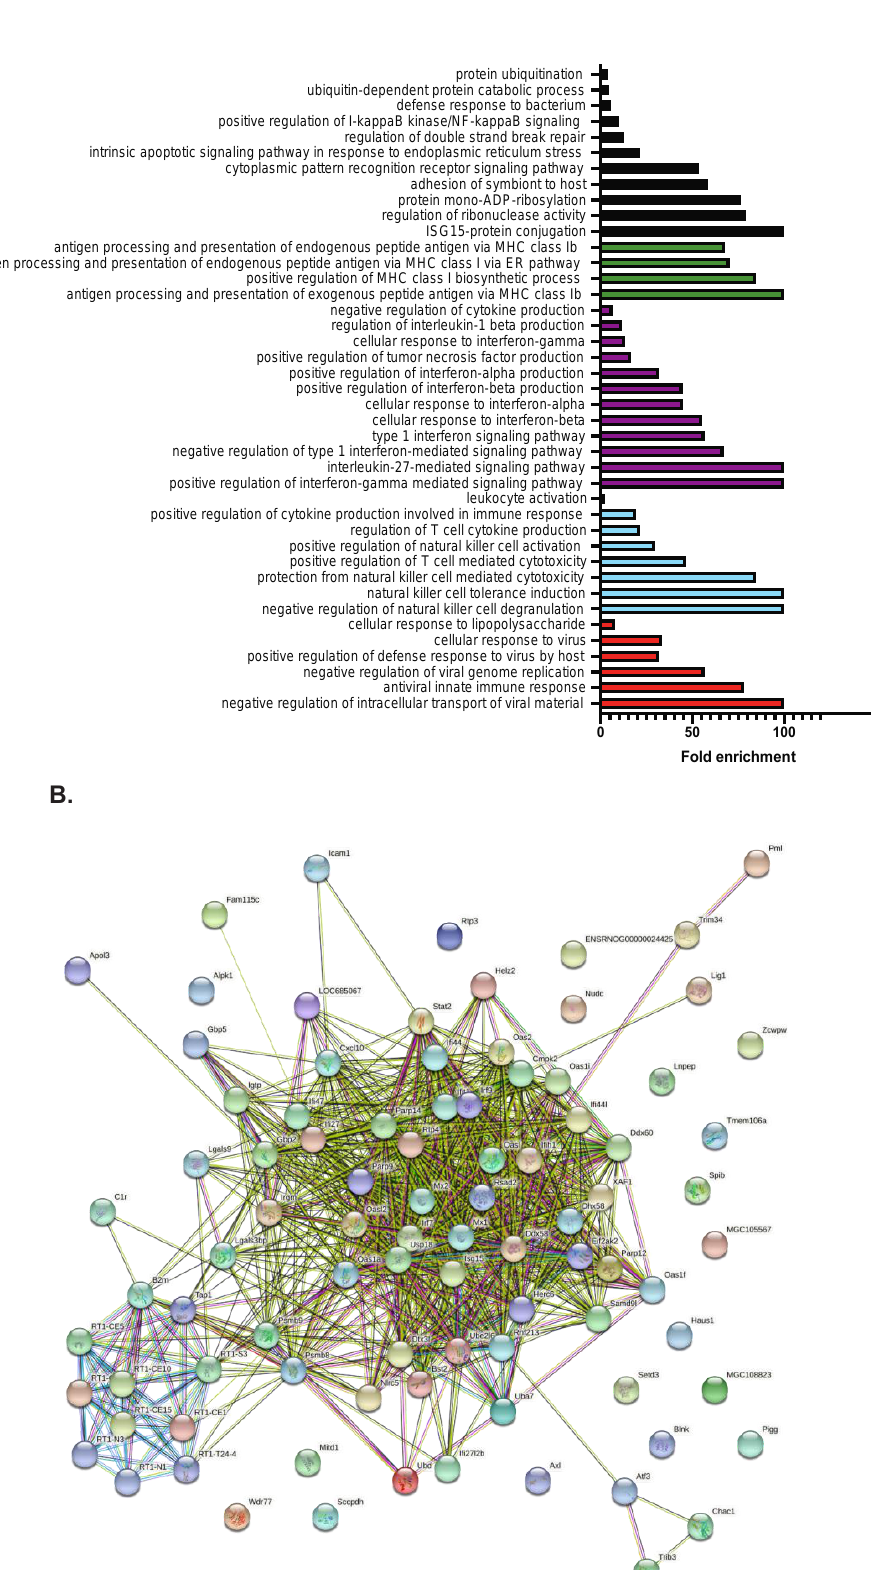
Figure 2. RNA-seq analysis of INS-1 cells overexpressing hsTCF19 identifies upregulated genes that form a tight node of interconnected genes with roles in viral, immune, and interferon response pathways ( A ) PANTHER overrepresentation test for GO biological processes on >2- fold upregulated genes show enrichment for genes involved in viral responses (red), regulation of im- mune response processes (blue), regulation of cytokines (purple), and antigen presentation (green). Additionally, other processes such as regulation of double strand break repair, apoptotic signaling pathway in response to ER stress, and positive regulation of NF-κB signaling were also overrepresented (black) (FDR < 5%). ( B ) STRING analysis on differentially expressed genes with >2-fold upregulation shows tightly interconnected network of genes. Among the upregulated genes (Table S1), several are known to be involved in DDR and repair pathways (Parp9, Parp10, Parp12, Parp14) [37]. In particular, Parp9 and another gene from the dataset, Dtx3l , have been shown to work as a complex to promote DNA repair [38]. Other significantly upregulated genes include those from the oligoadenylate synthase (Oas) family (Oas1i, Oasl2, Oas2, Oas1a, Oas1g, Oas1f ), which are stimulated by type 1 interferons in response to viral infections [39]. However, they can also be activated by DNA damage, where they may have roles in Poly(ADP-ribose) (PAR) synthesis and interacting with PARP1 during DNA repair [39,40]. Mx1 , Ddx60, and Usp18 are genes with known antiviral roles and were also significantly upregulated [41–43]. These observations suggest that TCF19 may play a previously unreported role in the DDR and viral and in- flammatory response pathways. To assess the extent to which the findings in this overexpression model could be translated to human islets, we overexpressed hsTCF19 in human islets (Figure 3A) and assessed several of the differentially expressed genes from the RNA-seq dataset (Figure 3B). Notably, transcript levels for DDR genes PARP9 and DTX3L were significantly up- regulated in human islets overexpressing hsTCF19 compared to the empty vector control